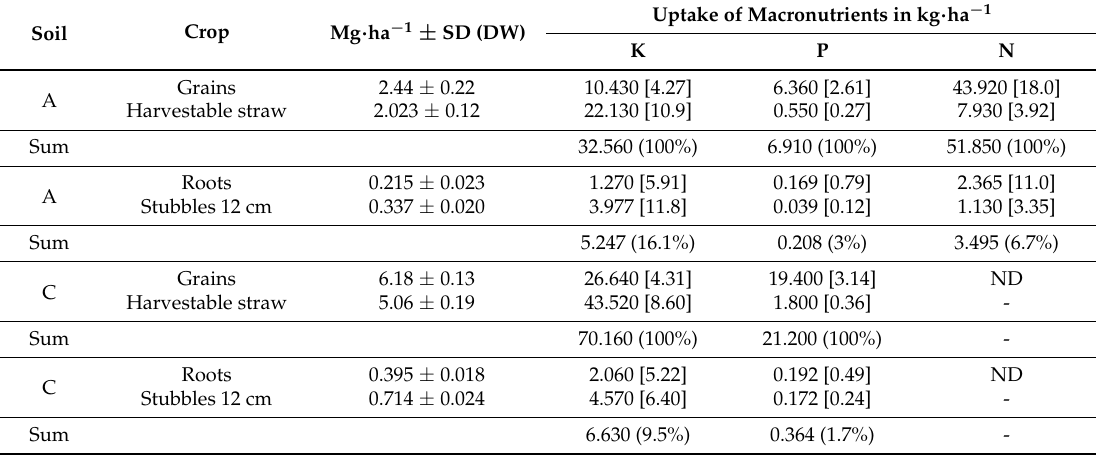
Table 6. The approximate order of N, P, and K extraction (kg · ha − 1 ) by cv. JB Asano from soils A and C. Compare Tables 1–4 for primary data. In parentheses, the percentages of minerals in roots/stubbles to those of the harvestable crop. In brackets [ ], the mineral concentrations of the herbage (kg · Mg − 1 ·